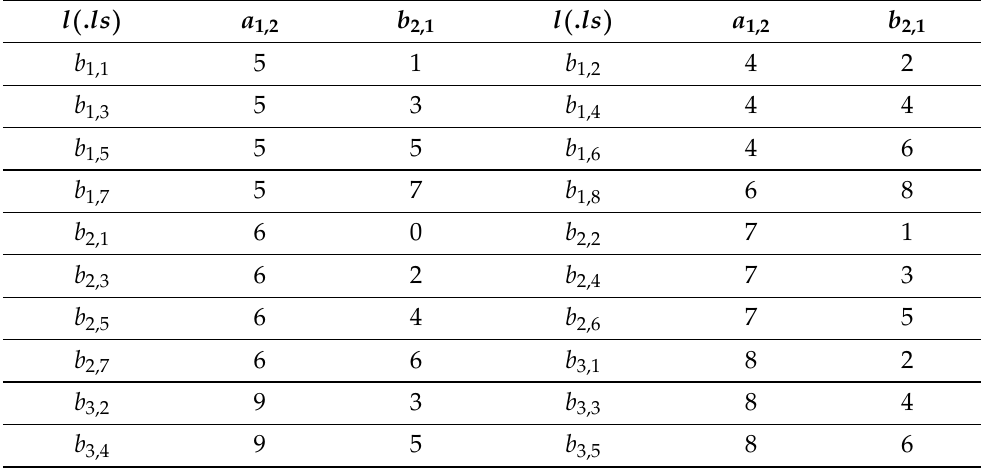
Table 4. Locations of the nodes of GHCN ( 2,3,2 )